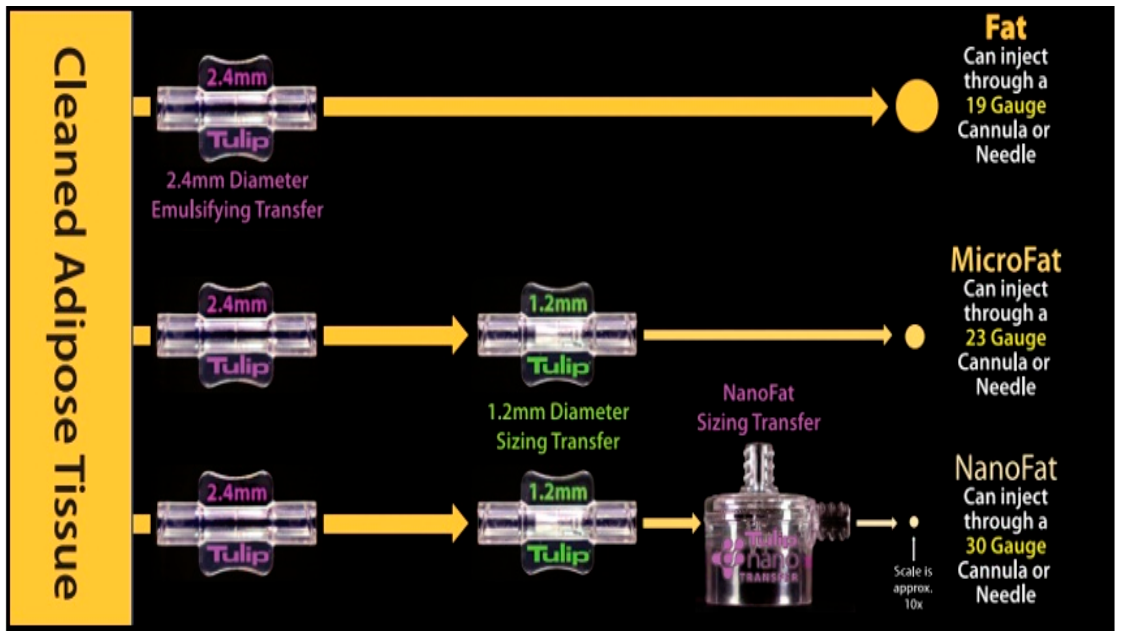
Figure 1. Harvested fat processing procedure sequence .